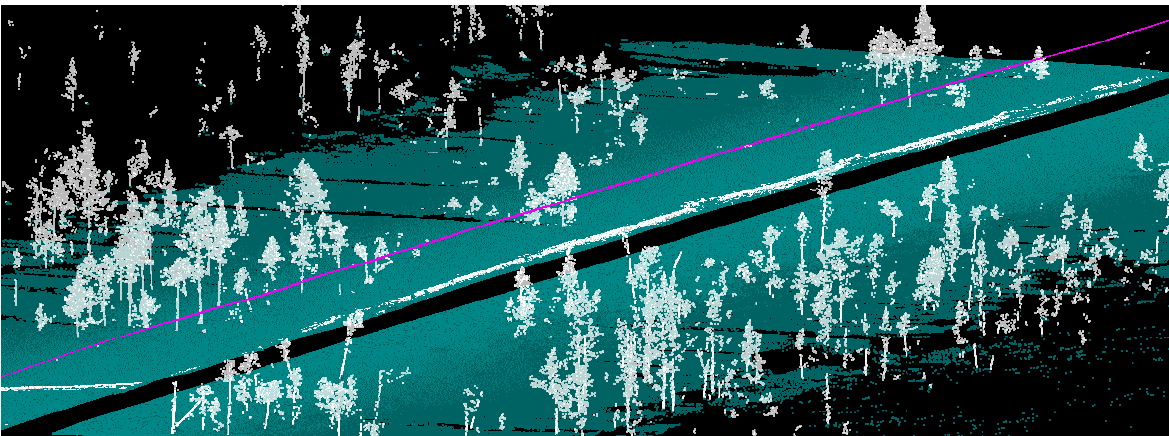
Figure 9. Snow surface and trees detected by classifying the MLS data. The purple line shows the scanner